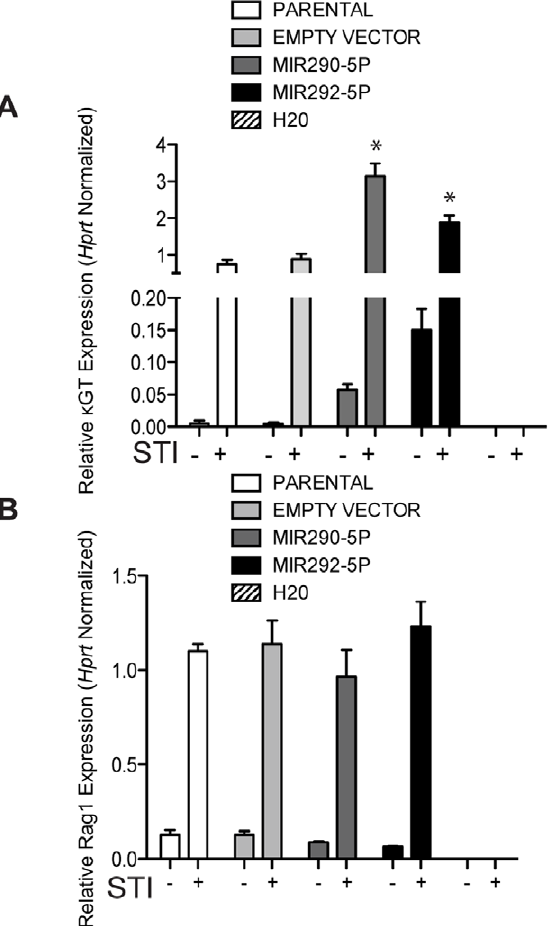
Figure 2. Over-expression of miR290-5p or miR292-5p induces k GT expression in AMuLV cells. 2A, B. qPCR analysis of (A) k GT or (B) Rag1 expression in RNA purified from E2A + / + AMuLV cells over- expressing either miR290-5p or miR292-5p, cultured in the absence or presence of STI571 (2.5 m M, 12 hr). The (A) k GT qPCR y-axis reflects two different scales. Data was normalized to the expression of Hprt . Error bars represent range for replicate qPCR reactions. Asterisk represents P value , 0.05. The P value was derived by the Student’s T test. Data shown is from one representative experiment of at least four individual